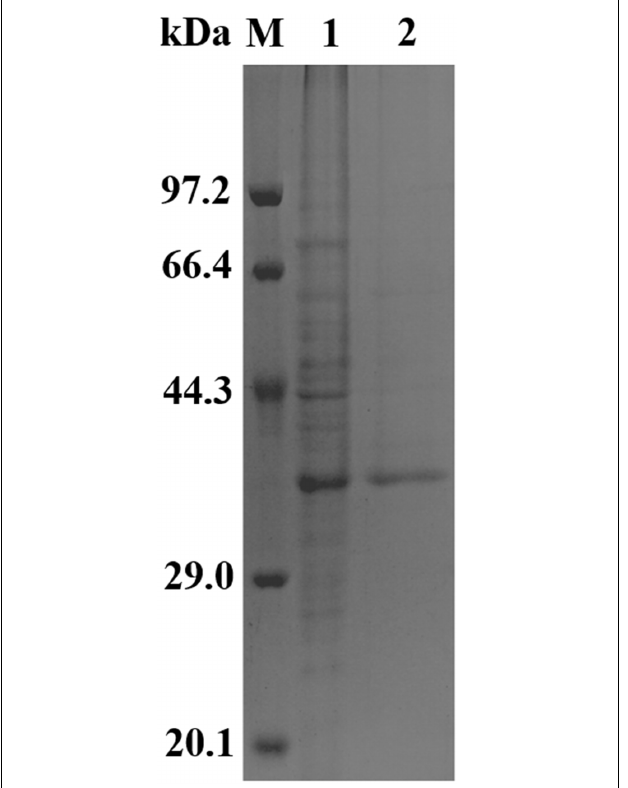
FIGURE 3 | Sodium dodecyl sulfate-polyacrylamide gel electrophoresis analysis of the purified recombinant Aii810. Protein markers (lane M) stained with Coomassie blue, supernatant of E. coli BL21 (DE3) cell lysates (lane 1), purified target protein (lane 2). The molecular mass of the enzyme subunit was estimated using the following protein markers as standards: rabbit muscle phosphorylase B (97,200 Da); bovine serum albumin (66,409 Da); ovalbumin (44,287 Da); carbonic anhydrase (29,000 Da); soybean trypsin inhibitor (20,100 Da).